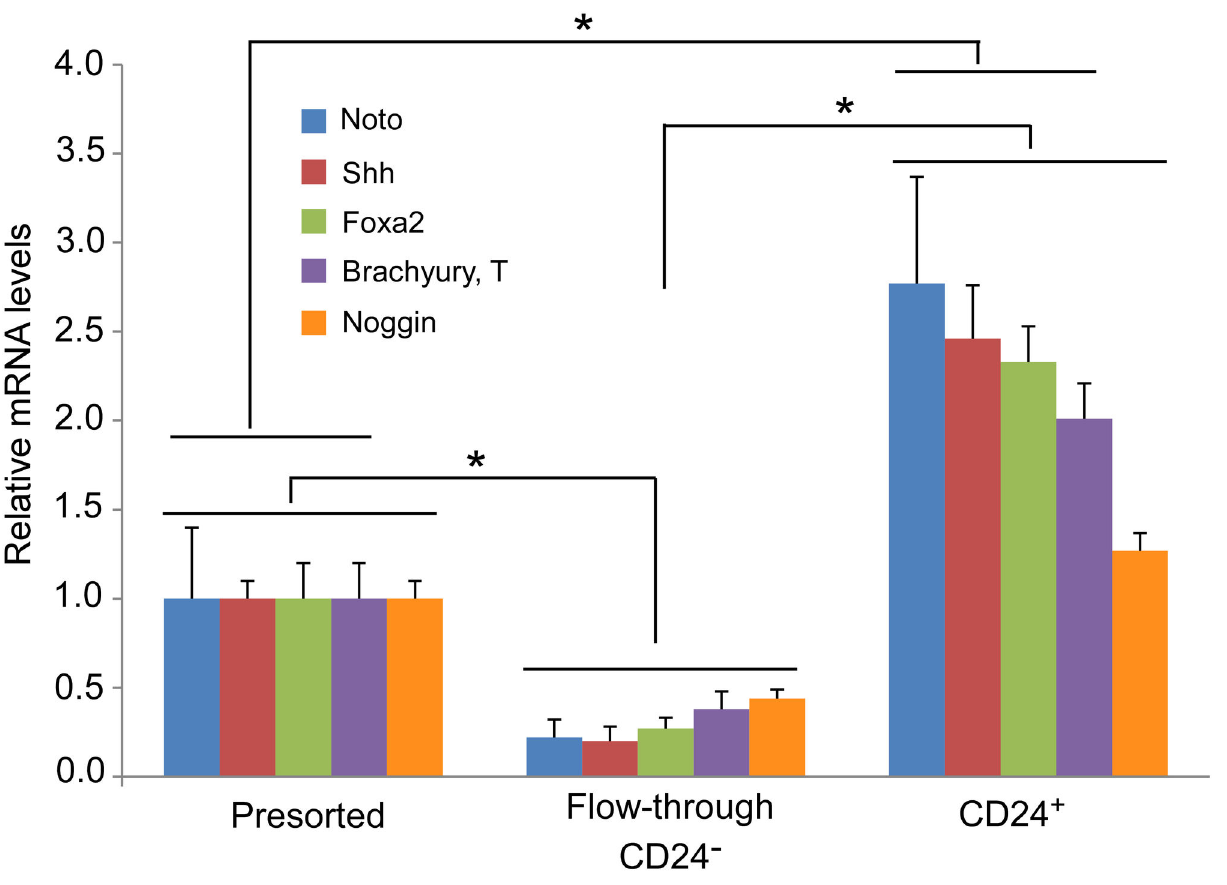
Figure 3. Relative mRNA levels in undifferentiated, presorted iPSC populations, “flow-through” and sorted CD24 + fractions for notochordal markers ( Noto, Shh, Foxa2, Brachyury and Noggin ). Data are expressed as fold-difference (2 -ΔΔCt , n=3 independent sorting experiments, mean+SE) between sorted CD24 + or “flow-through” and presorted samples. The relative mRNA level in presorted cells was set as the calibrator (value=1) for normalizing the relative mRNA levels in the CD24 + cell fraction and “flow-through” fraction (* p<0.01, ANOVA: significant fold-difference detected between presorted cells and CD24 + cells or CD24 - cells in “flow-through”, and between CD24 - cells in “flow-though” and CD24 + cells). Differences were detected in all targets except for Noggin between unsorted cells and sorted CD24 +